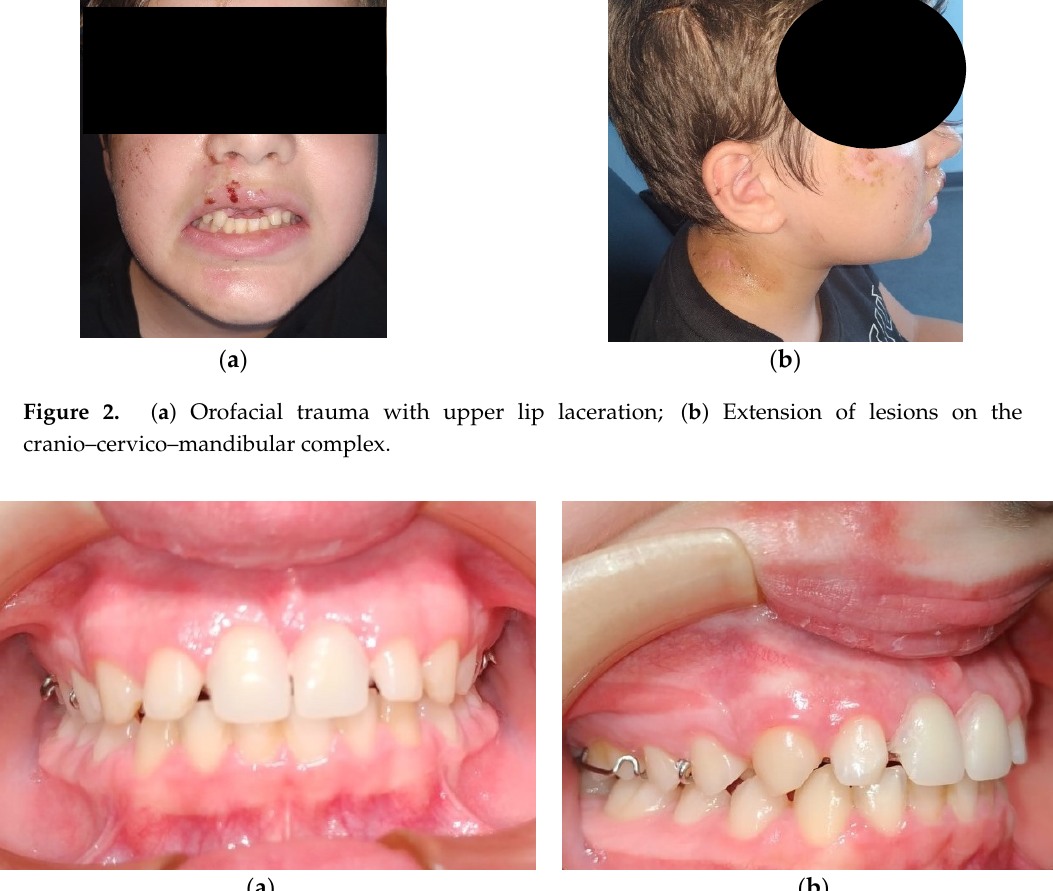
Figure 3. ( a ) Intra-oral view of the Hawley appliance with two central incisors; ( b ) Lateral right view of the occlusion of the trumpet player and the appliance.